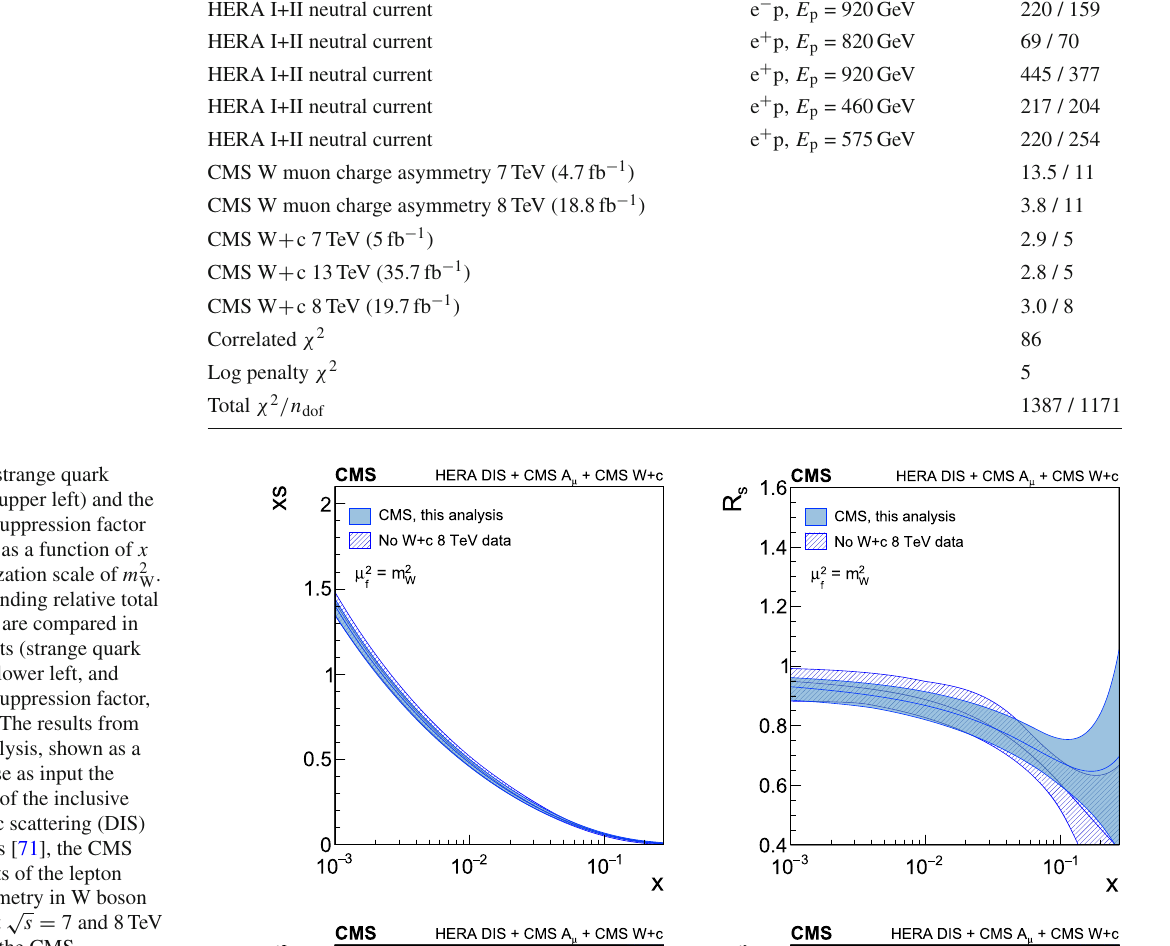
Table 13 The partial χ 2 per number of data points, n dp , and the global χ 2 per number of degrees of freedom, n dof , resulting from the PDF fit